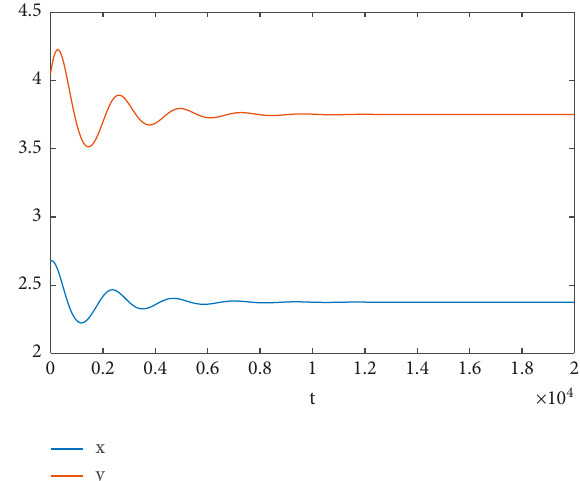
Figure 1: The stability of the system (1) without diffusion when r